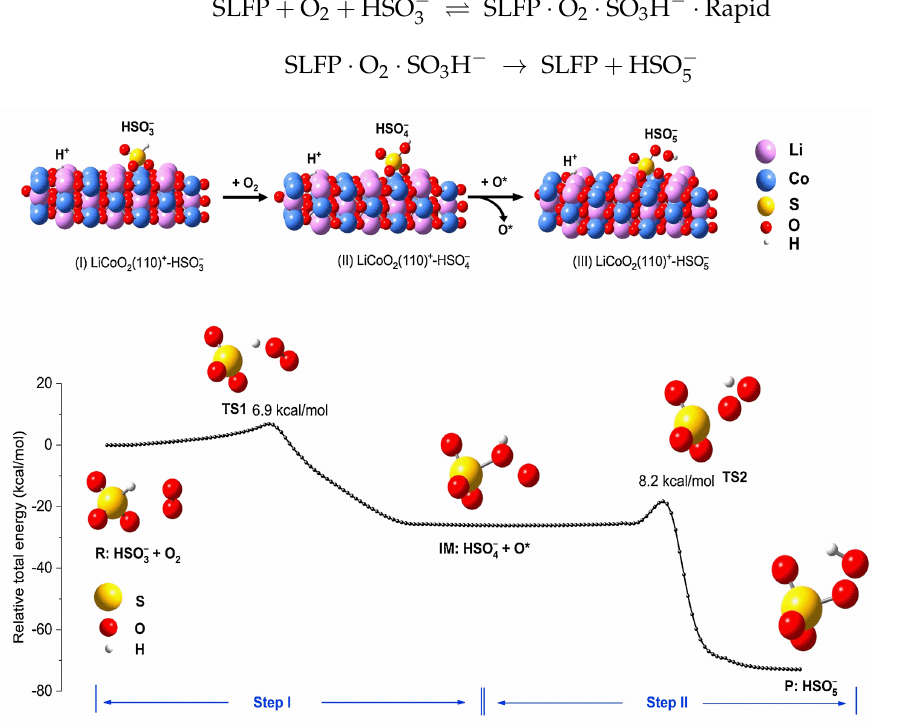
Figure 5. Adsorption structures of HSO 3 − , HSO 4 − , and HSO 5 − species on LiCoO 2 (110) surface as optimized by first − principles DFT calculations and potential energy profiles for two − step hydrogen shifts to form HSO 5 − during the reaction of HSO 3 − with O 2 by intrinsic reaction coordinate calculations. Structures of reactant (R), intermediate (IM), product (P), and transition states (TS) are shown near the curve. Reprinted with permission from Ref. [86].